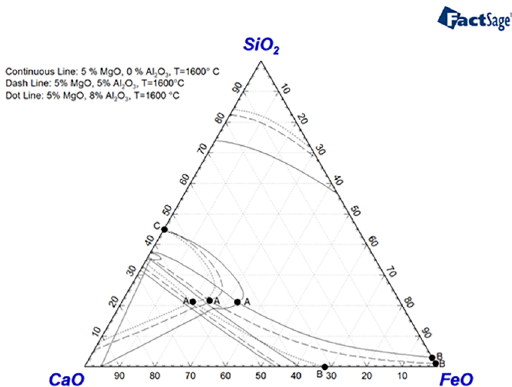
Figure 6. Superimposed liquid fields of the pseudo-ternary diagrams at 0%, 5%, and 8% Al